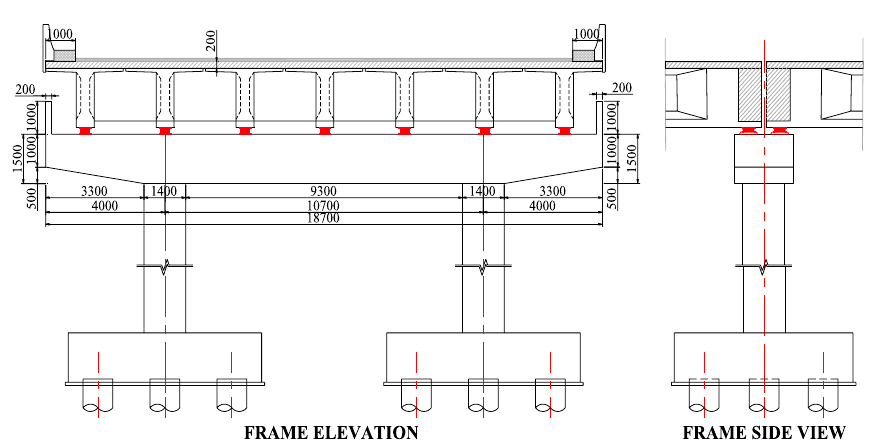
Fig. 6 Cross section of